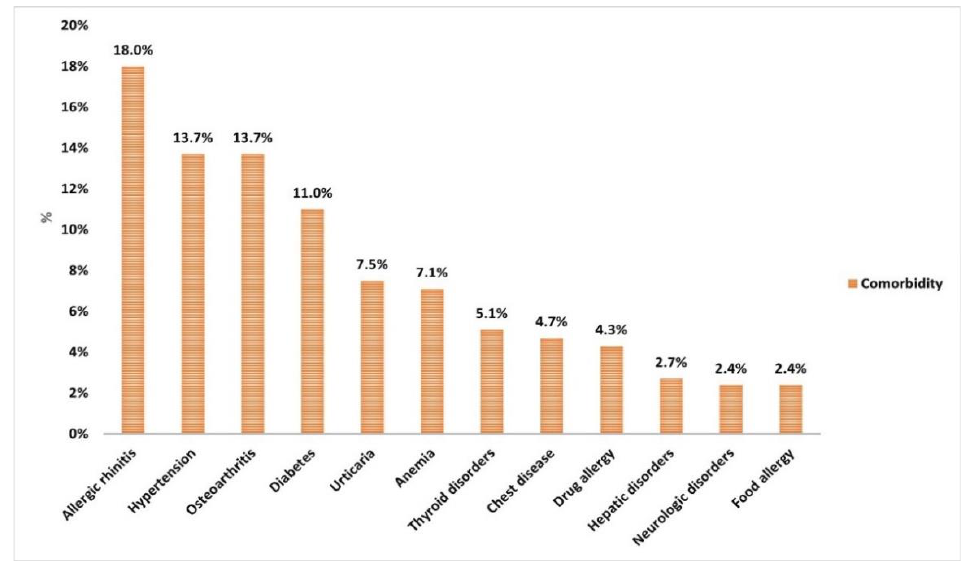
Figure 2. Associated comorbidities in descending order of frequency among study participants ( N = 255). ( N =